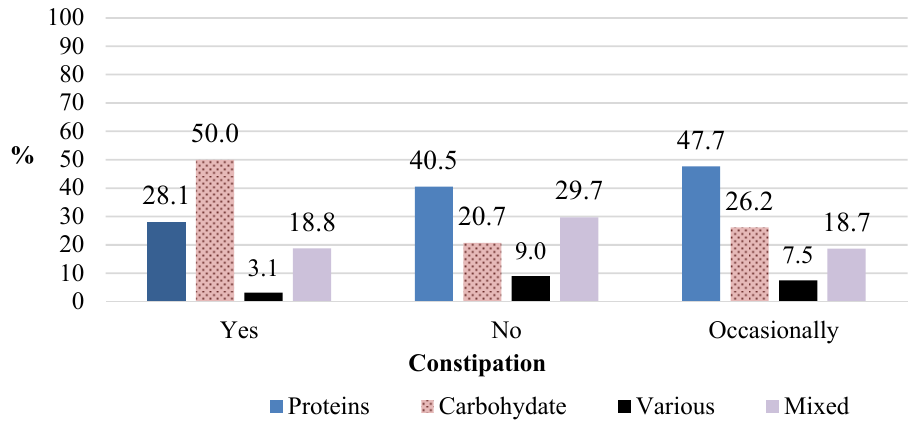
Fig. 3. Influence of nutrition on constipation in the study group (p=0.023), n=250